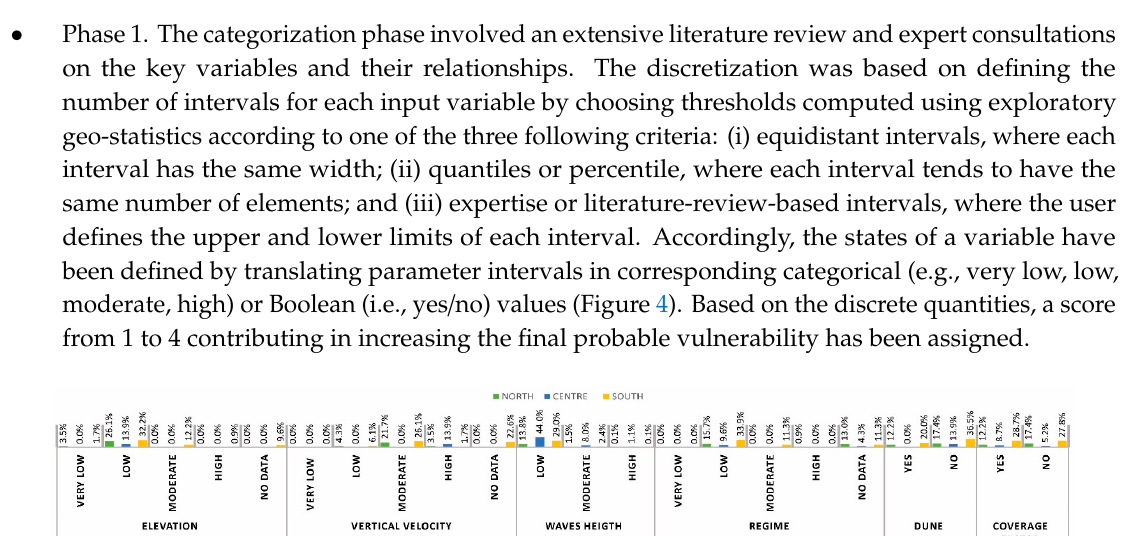
Figure 5. Bayesian belief network (BBN) conceptual model and associated source–pathway–receptor– consequence (SPRC_chain applied to the vulnerability assessment [78,79]. BBN conceptual model